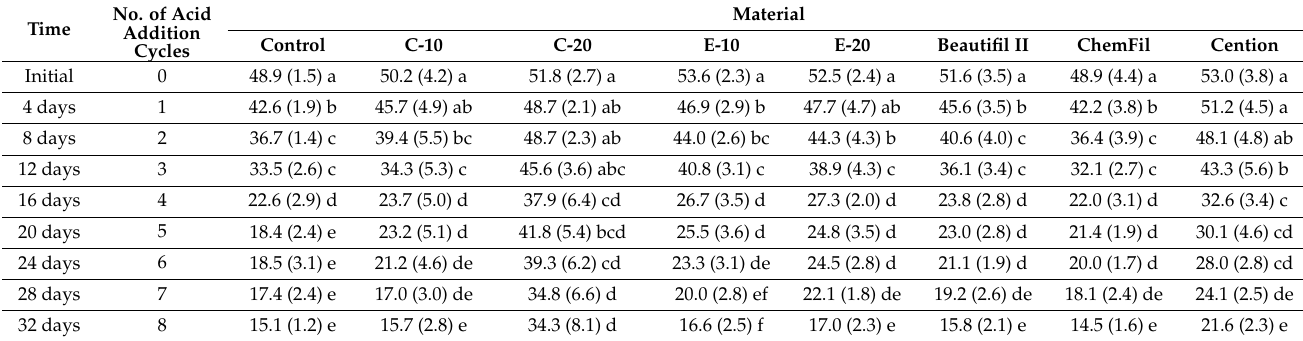
Time Table 3. Knoop microhardness of dentin samples (mean values with standard deviations in parentheses).